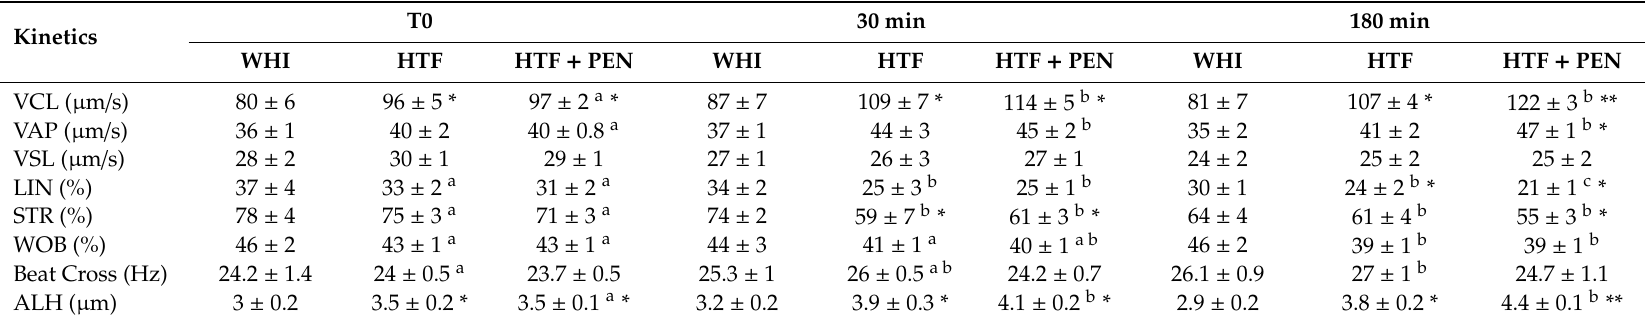
Table 1. Kinetics of stallion spermatozoa measured at time 0 (T0), and after 30 and 180 min of incubation at 37 ◦ C in a 5% CO 2 atmosphere in Whitten’s medium (WHI), synthetic human tubal fluid (HTF), and HTF supplemented with 750 µ M of penicillamine (HTF + PEN).